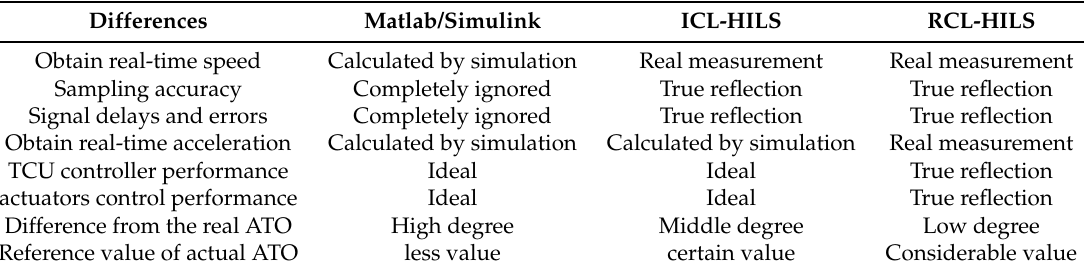
Table 3. Differences of three different simulation platforms.